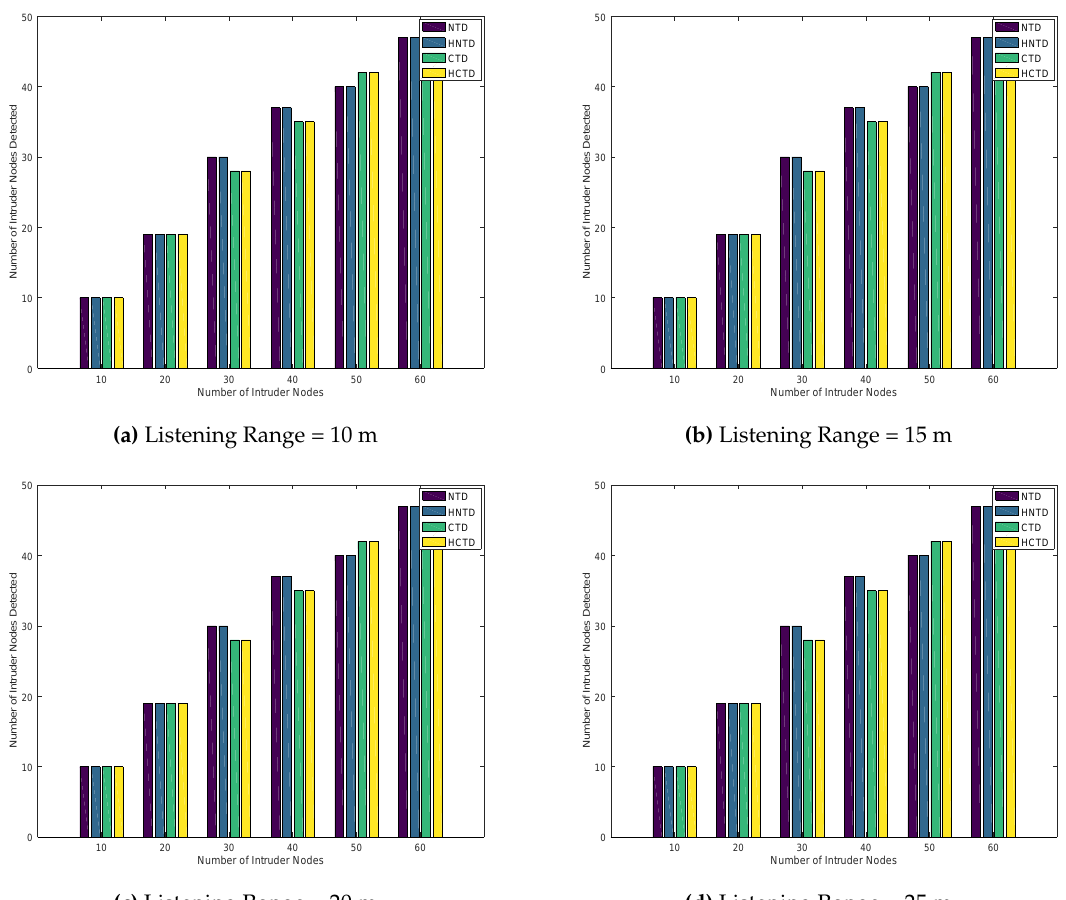
Figure 6. Number of Intruder Nodes Detected for Homogeneously placed